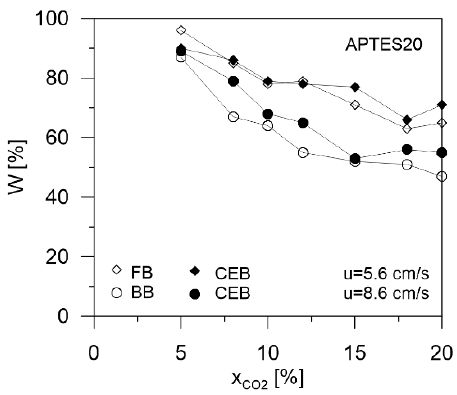
Figure 19. Fraction of bed used at increasing CO 2 concentrations for APTES20 at different contact modes and at two velocities.